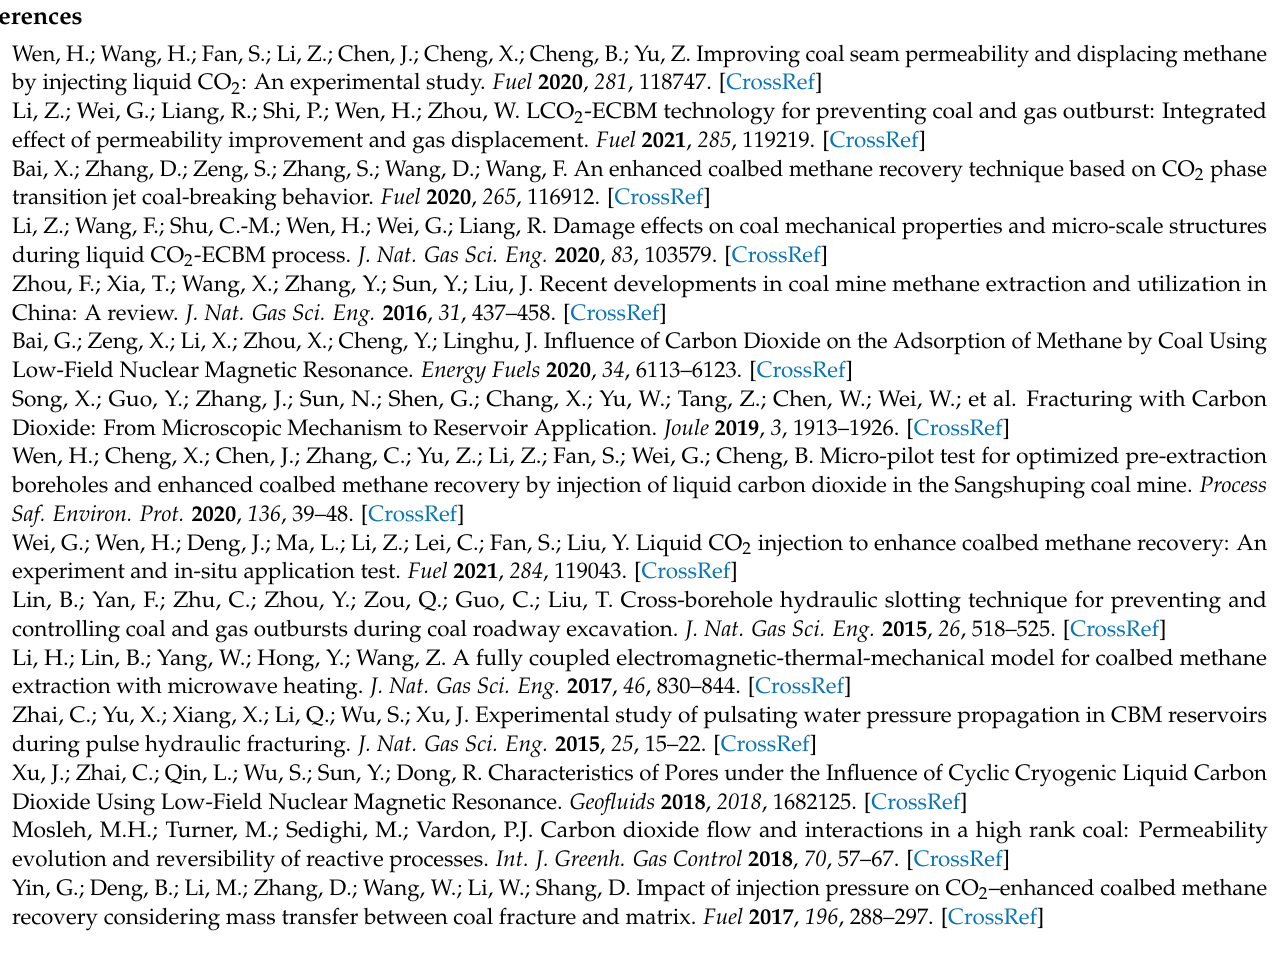
Figure S2. Schematic diagram of porosity percentage and cumulative porosity of gas coal at water- saturated and irreducible water conditions. Figure S3. Schematic diagram of porosity percentage and cumulative porosity of 1/3 coking coal at water-saturated and irreducible water